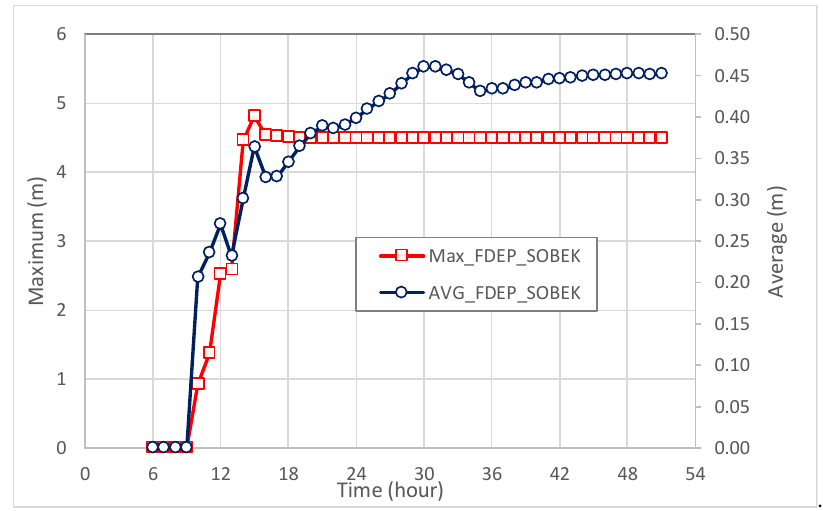
Figure 16. Maximum and average of the simulated inundation depths at the VIOT grids in the SOBEK model for the 921st simulation case.